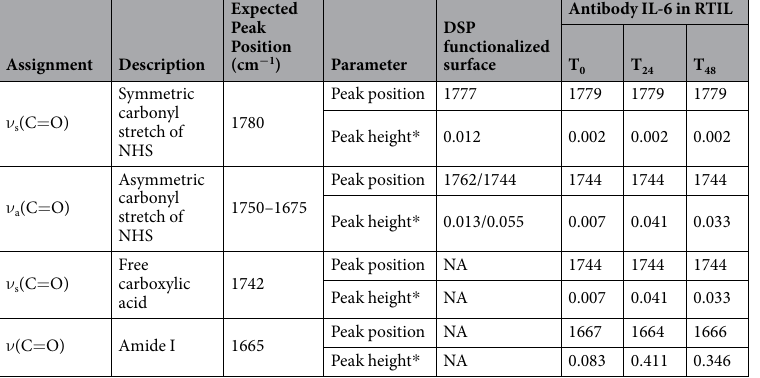
Table 2. Band assignments in DSP linker (blue) and in antibody (red) with their corresponding peak position and peak heights ( * relative